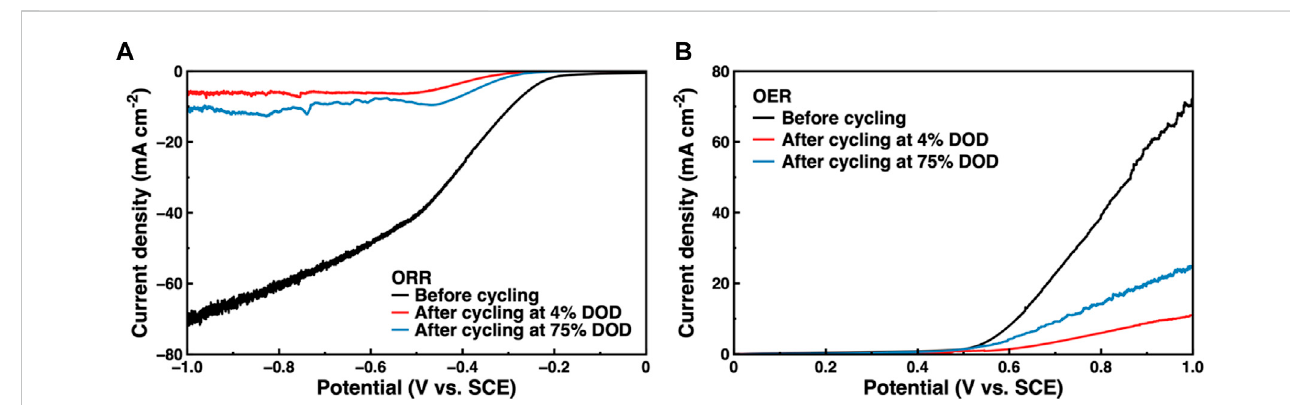
FIGURE 11 ORR/OER of Co 3 O 4 /CB air cathodes before and after cycling. (A) ORR results, and (B) OER results.